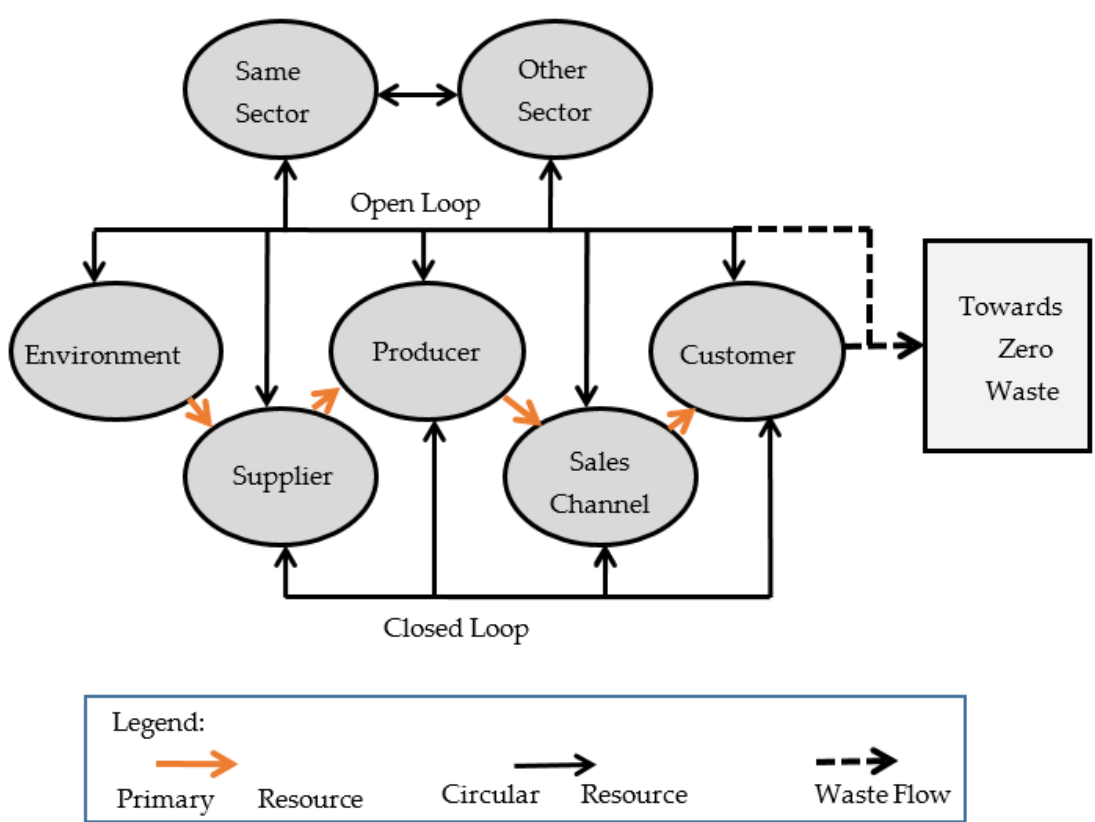
Figure 2. Circular Loop Model.